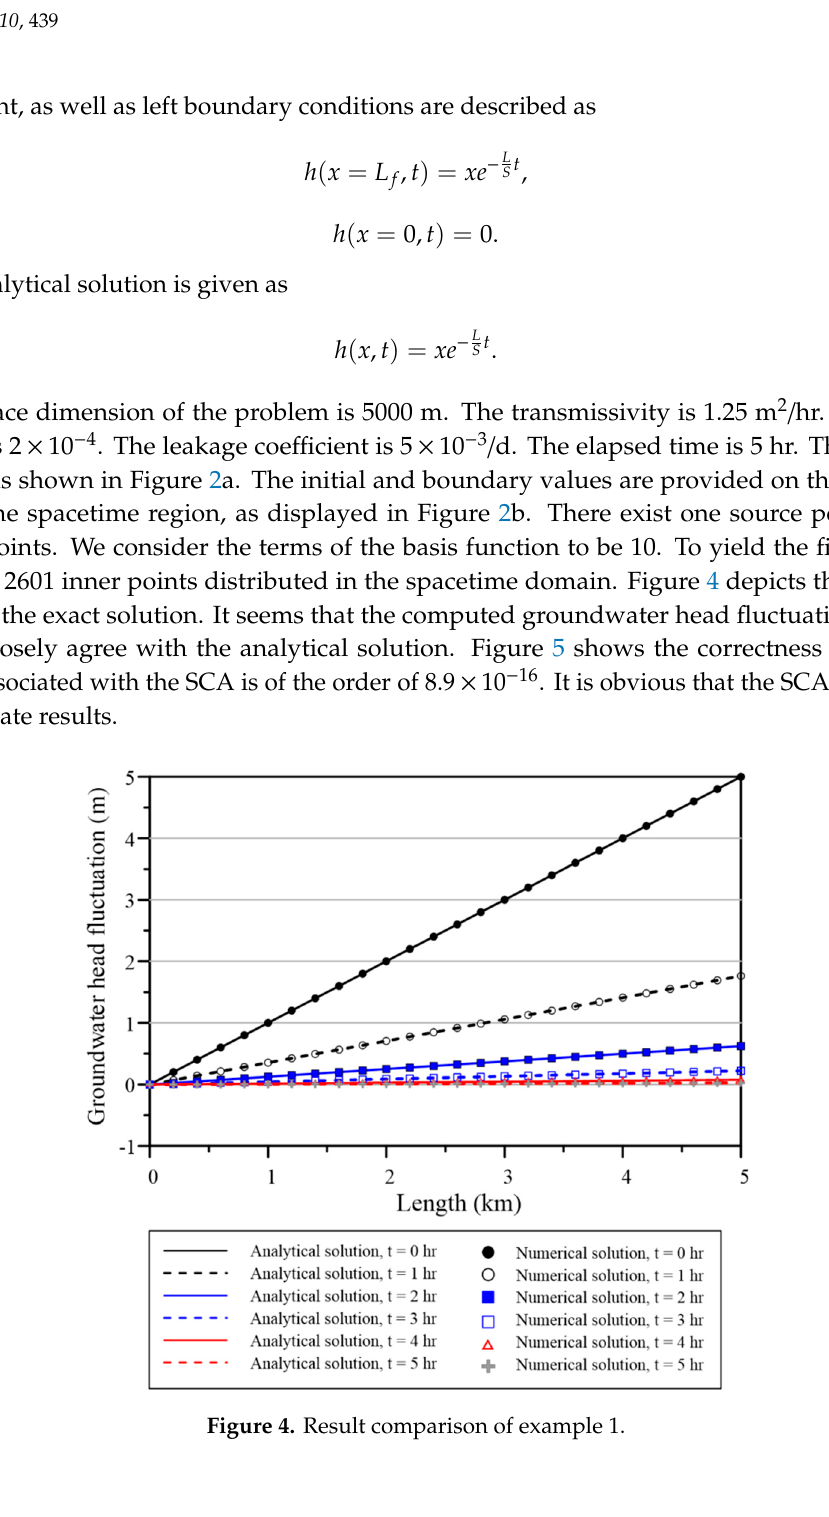
Figure 4. Result comparison of example 1.